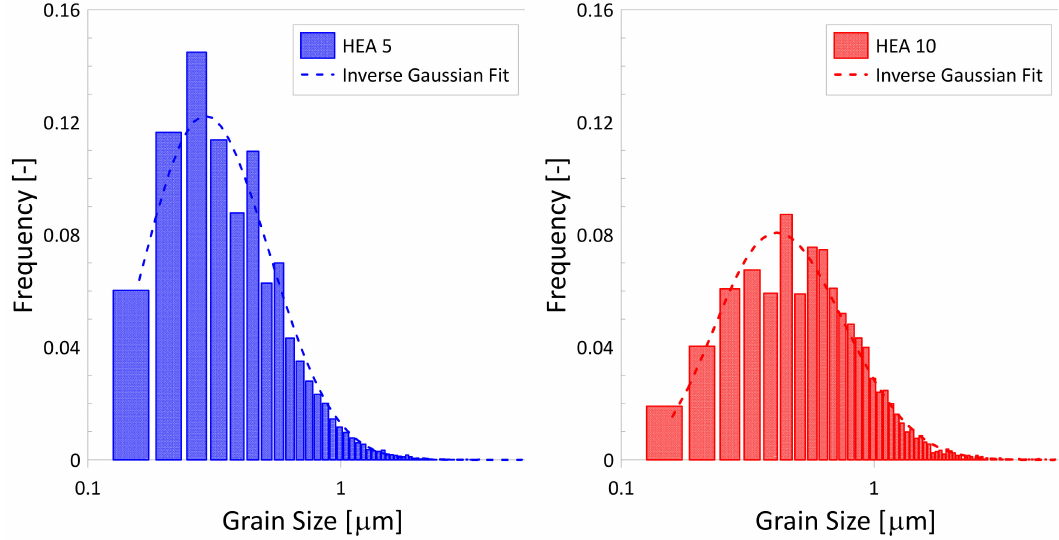
Figure 3. Grain size distribution in the log-normal scale for HEA 5 and HEA 10 with fitted inverse Gaussian distribution shown by dashed line.